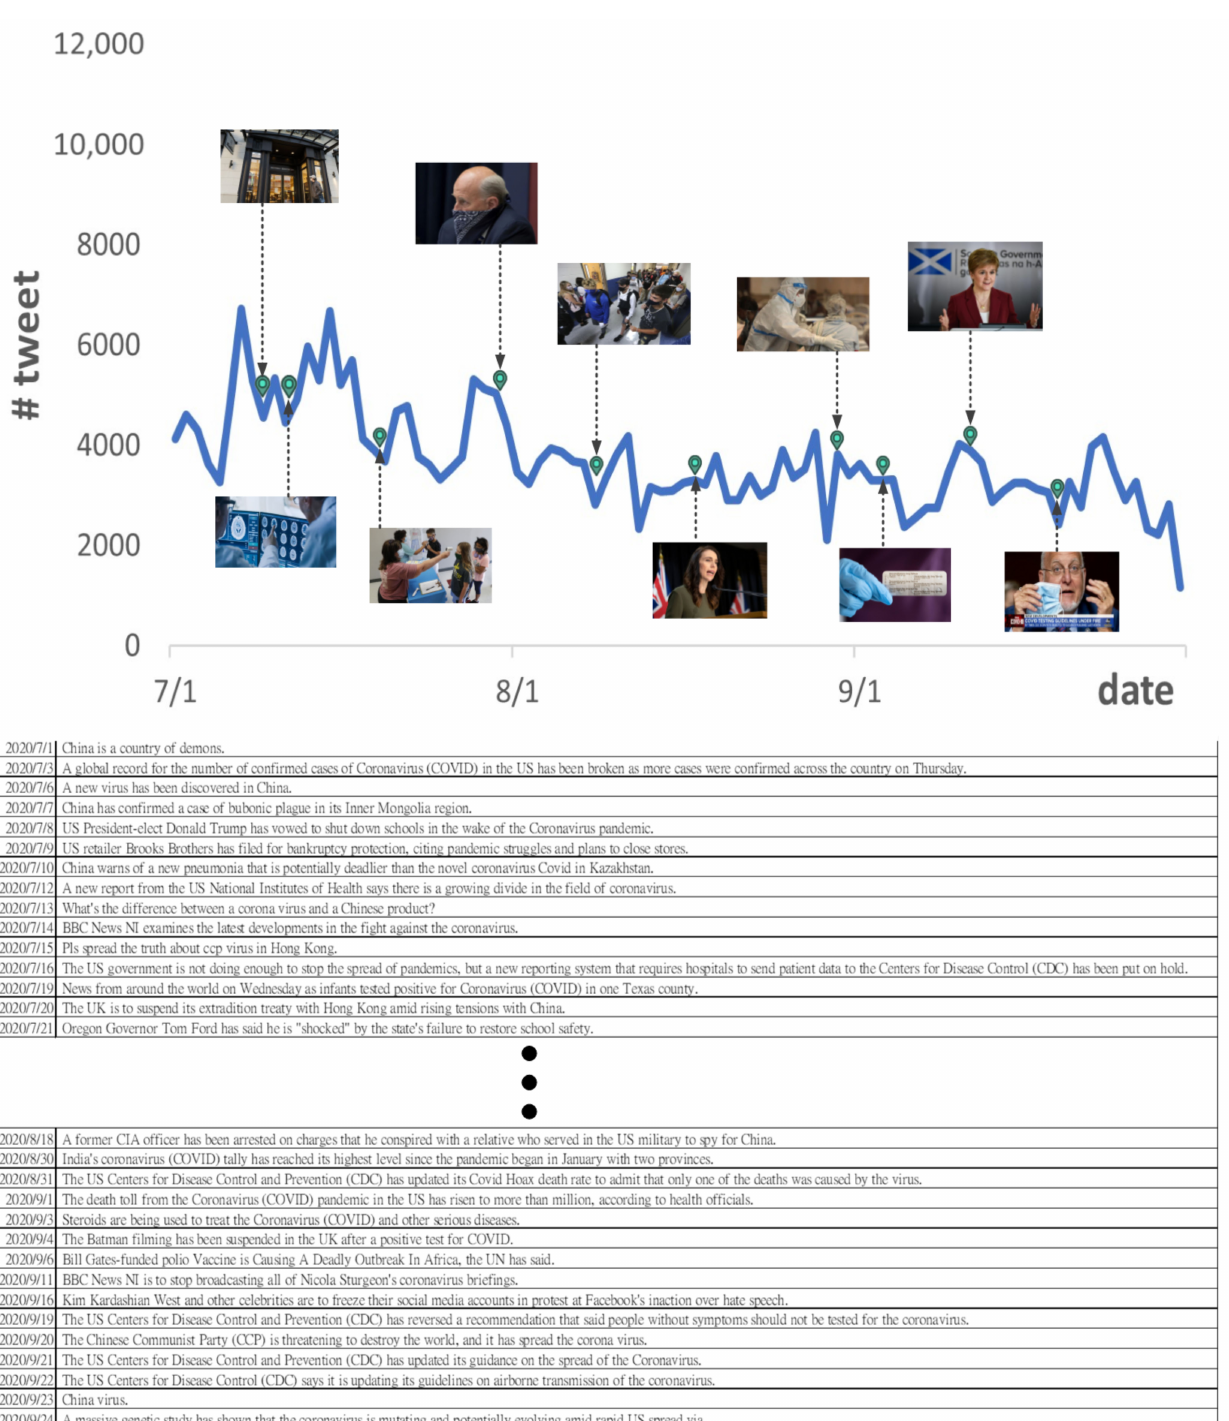
Figure A2. Generated storyline related to COVID-19 from July to September